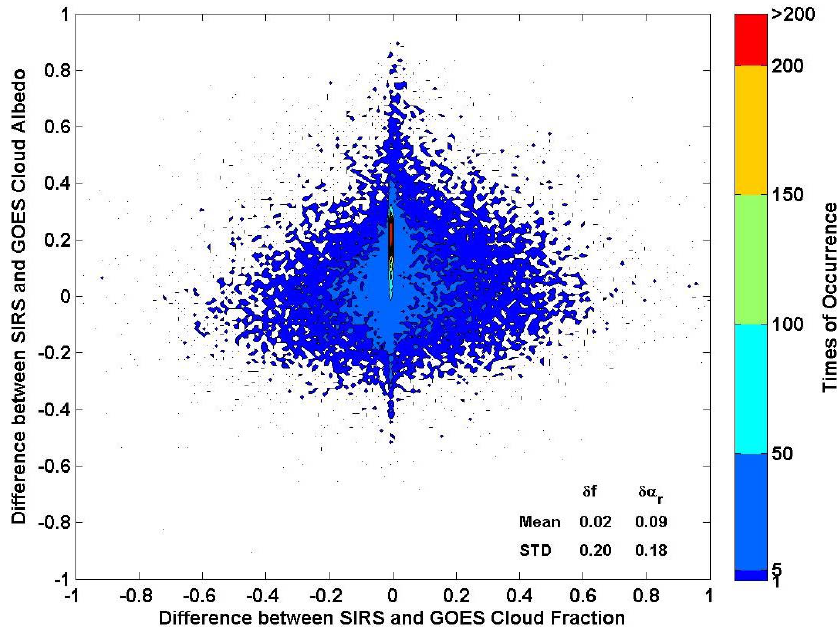
Fig. 3. Joint frequency distribution of the differences in cloud albedo and cloud fraction. The acronym STD denotes the standard